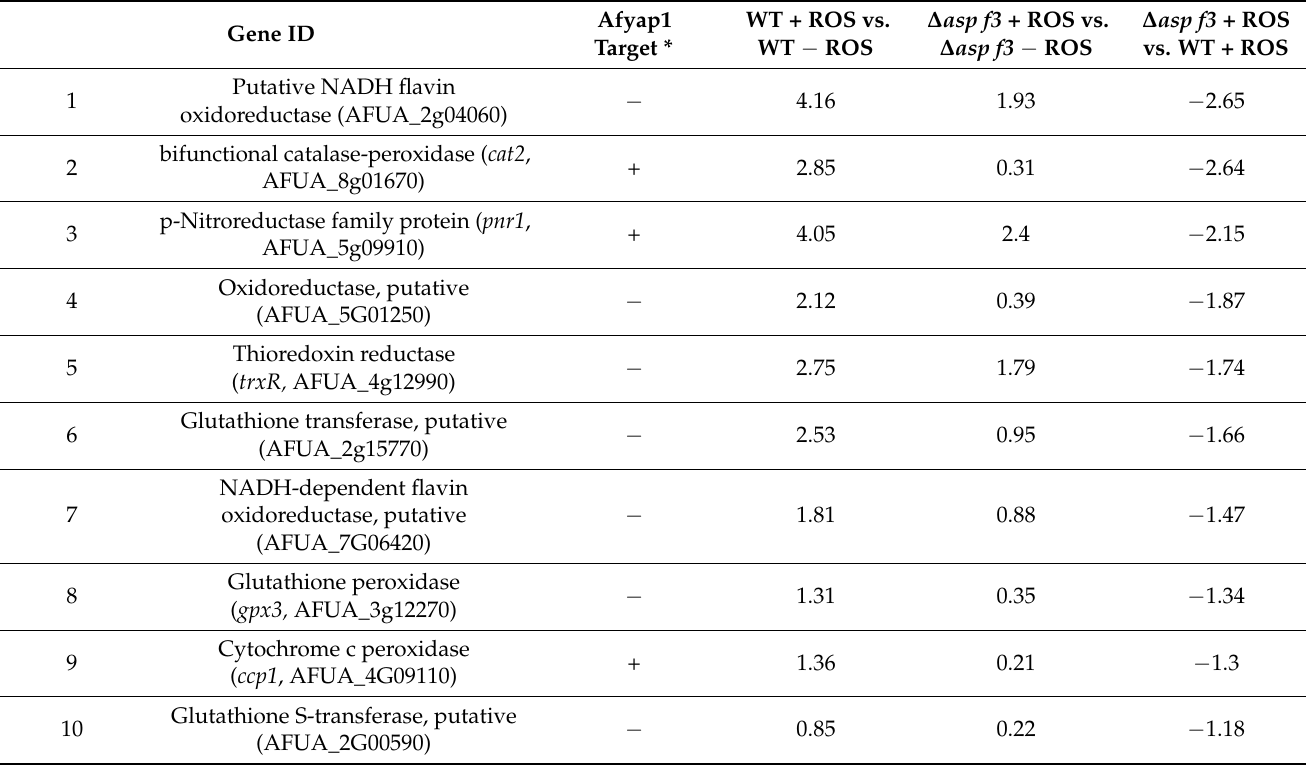
Table 2. Expression of oxidative stress genes in the Aspergillus fumigatus wild type and ∆ asp f3 in response to reactive oxygen species